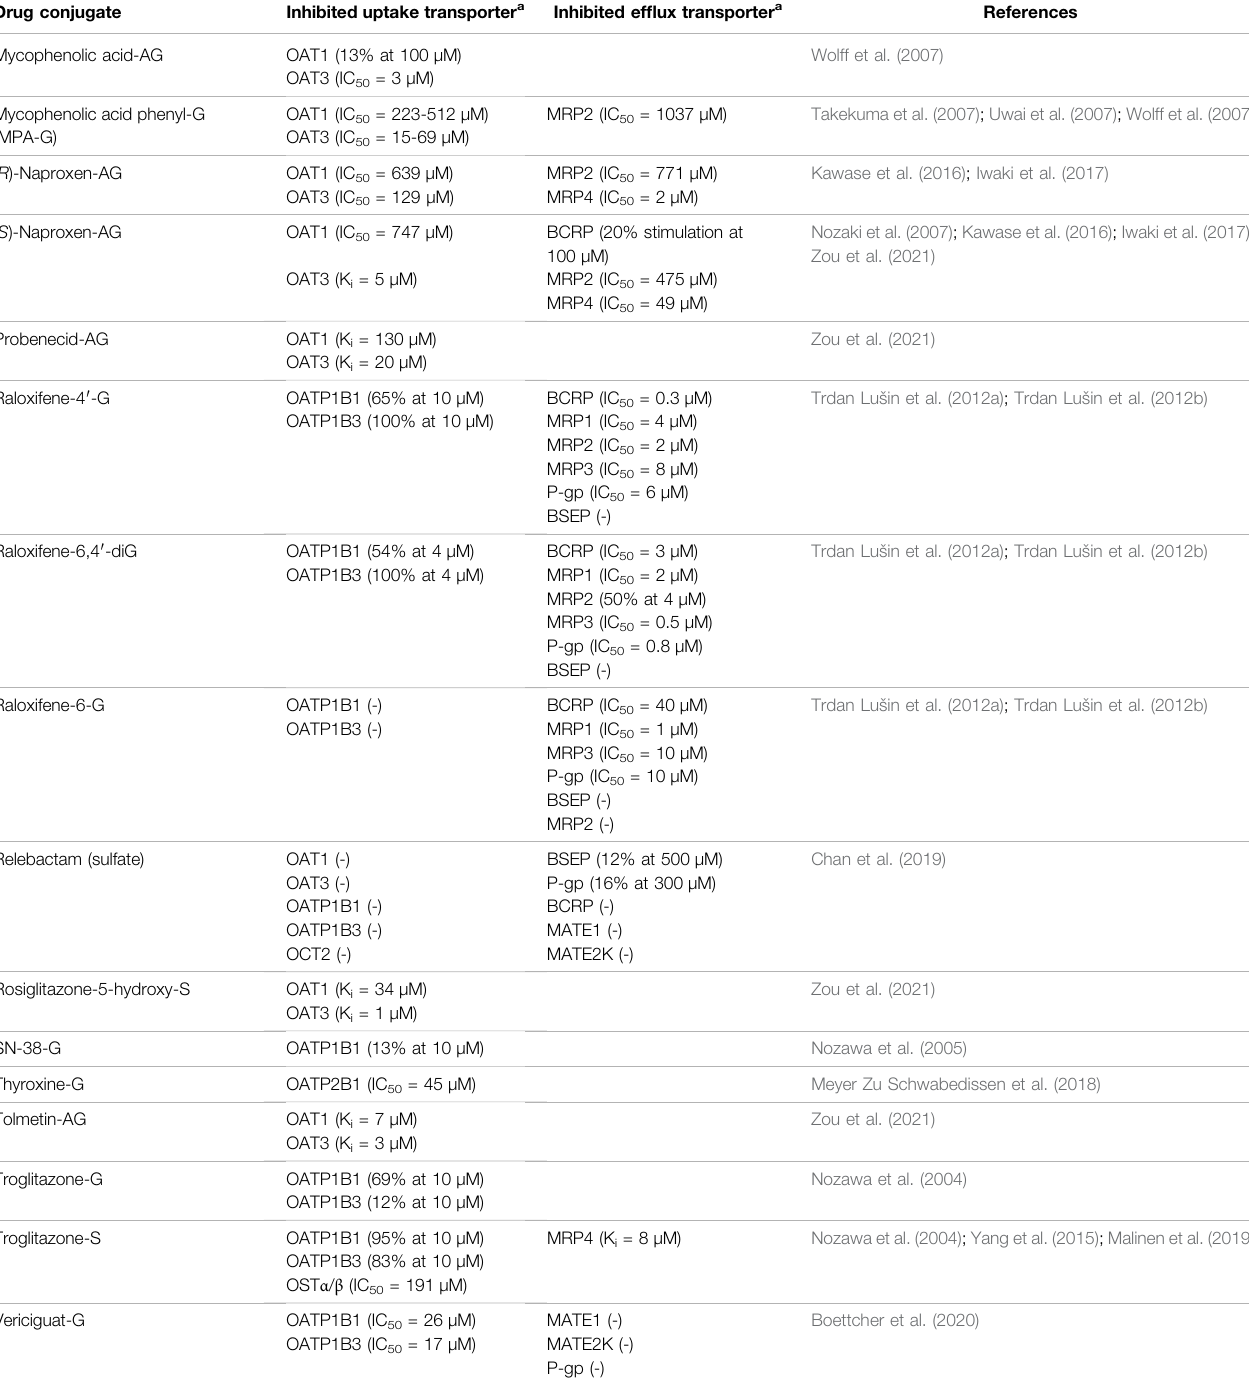
TABLE 2 | ( Continued ) Drug glucuronides (-G and -AG) and sulfates (-S) studied as inhibitors in transporter overexpression